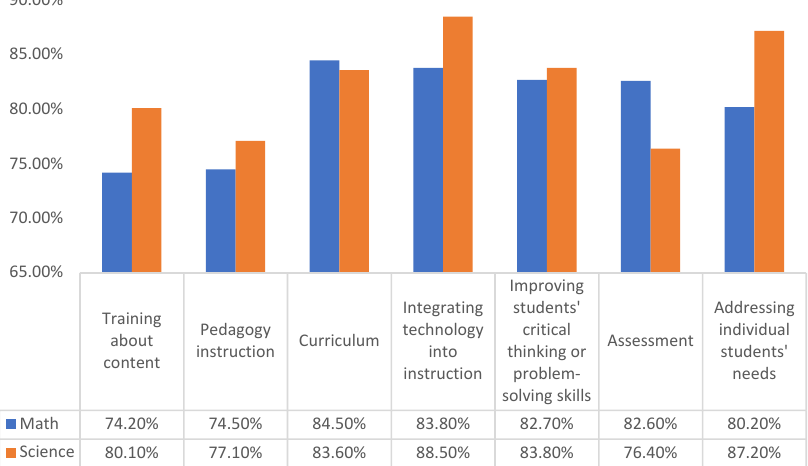
Figure 1. Teachers’ needs.